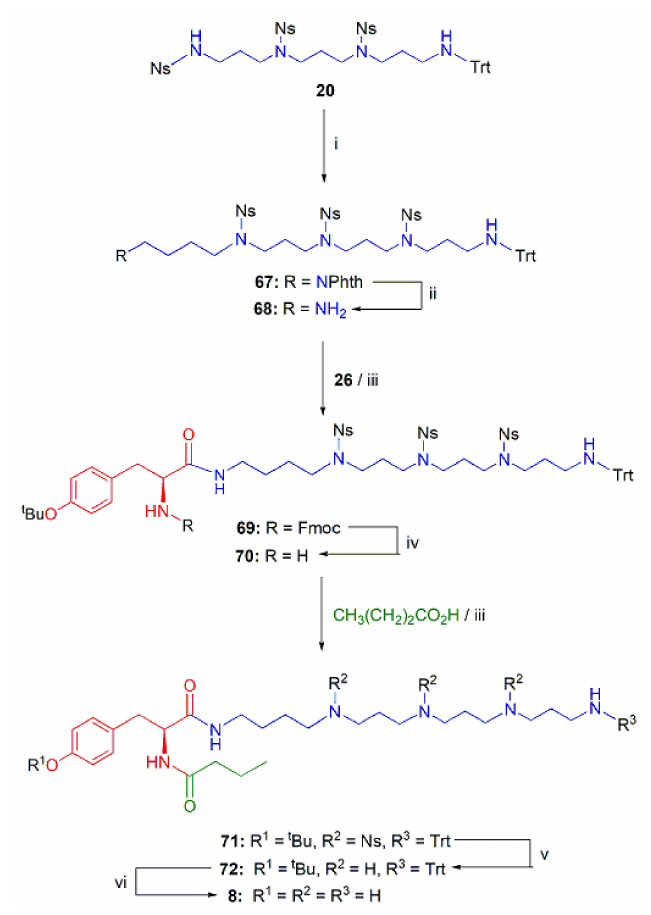
Scheme 6. Outline of synthetic route to PhTX-433 analog 8 . Reagents and conditions : (i) PhthN(CH 2 ) 4